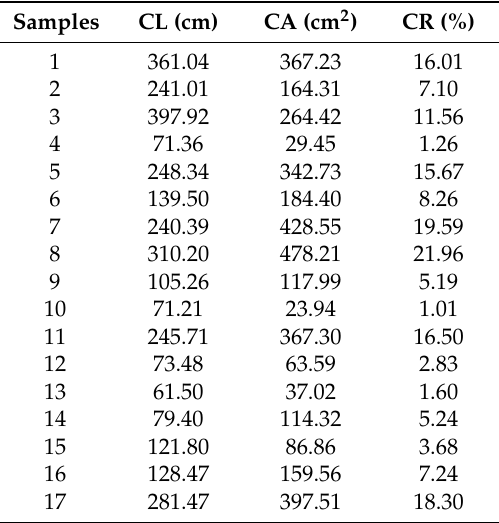
Table 3. Crack parameters of cracked soil